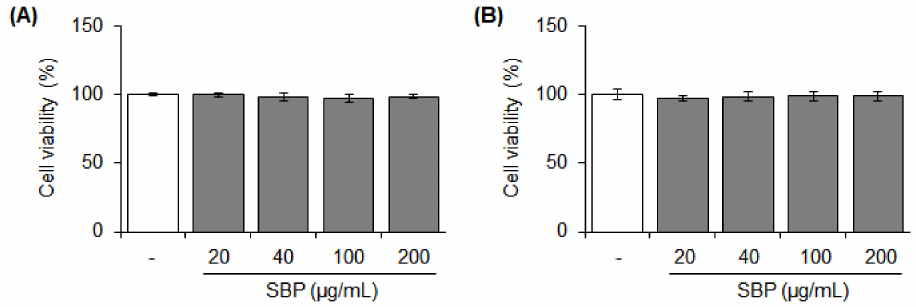
Figure 1. Cytotoxic effects of sword bean pod (SBP) extract on ( A ) Raw264.7 and ( B ) RBL − 2H3 cells. Data are expressed as mean ± SEM. SEM, standard error of the mean; SBP, sword bean pod.